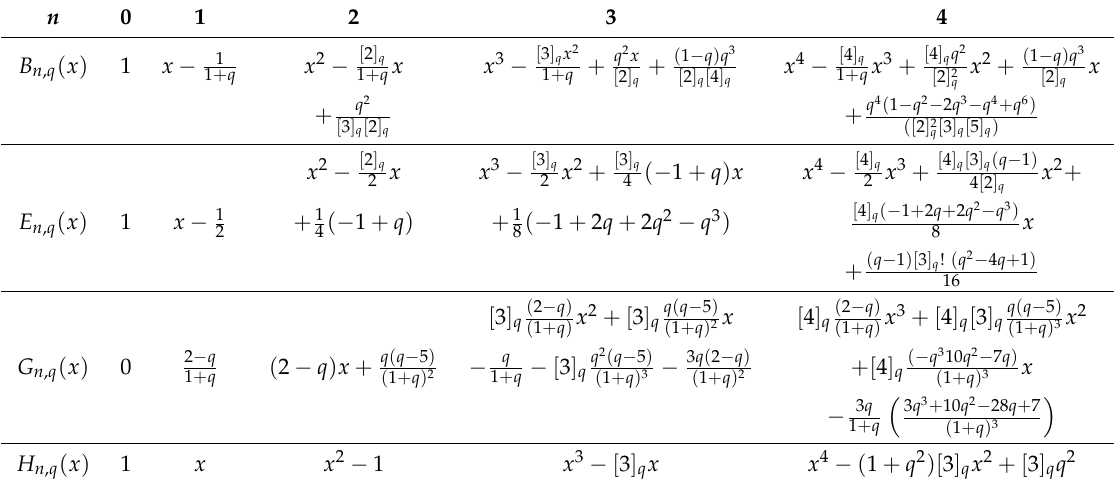
Table 2, the expressions of first five B n , q ( x ) , E n , q ( x ) , G n , q ( x ) and H n , q ( x ) are obtained and are mentioned in Table 5. Table 5. Expressions of first five B n , q ( x ) , E n , q ( x ) , G n , q ( x ) and H n , q ( x ) .